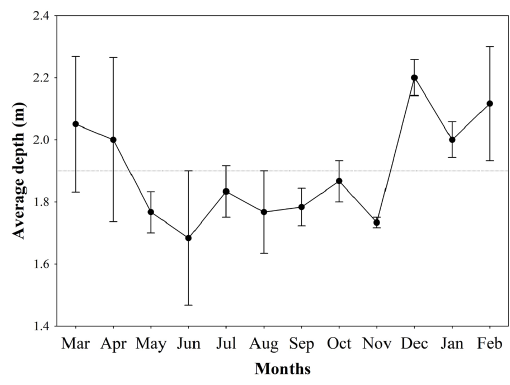
Figure 2. Average water depth registered at the Guaraná Lake during the study period (black dots = mean, bar = standard error).